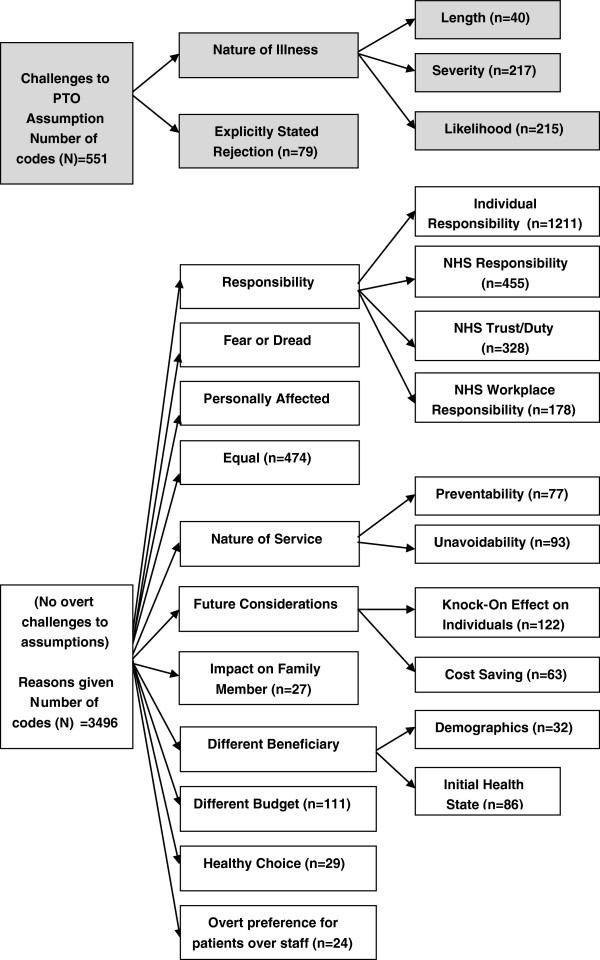
Coding framework.